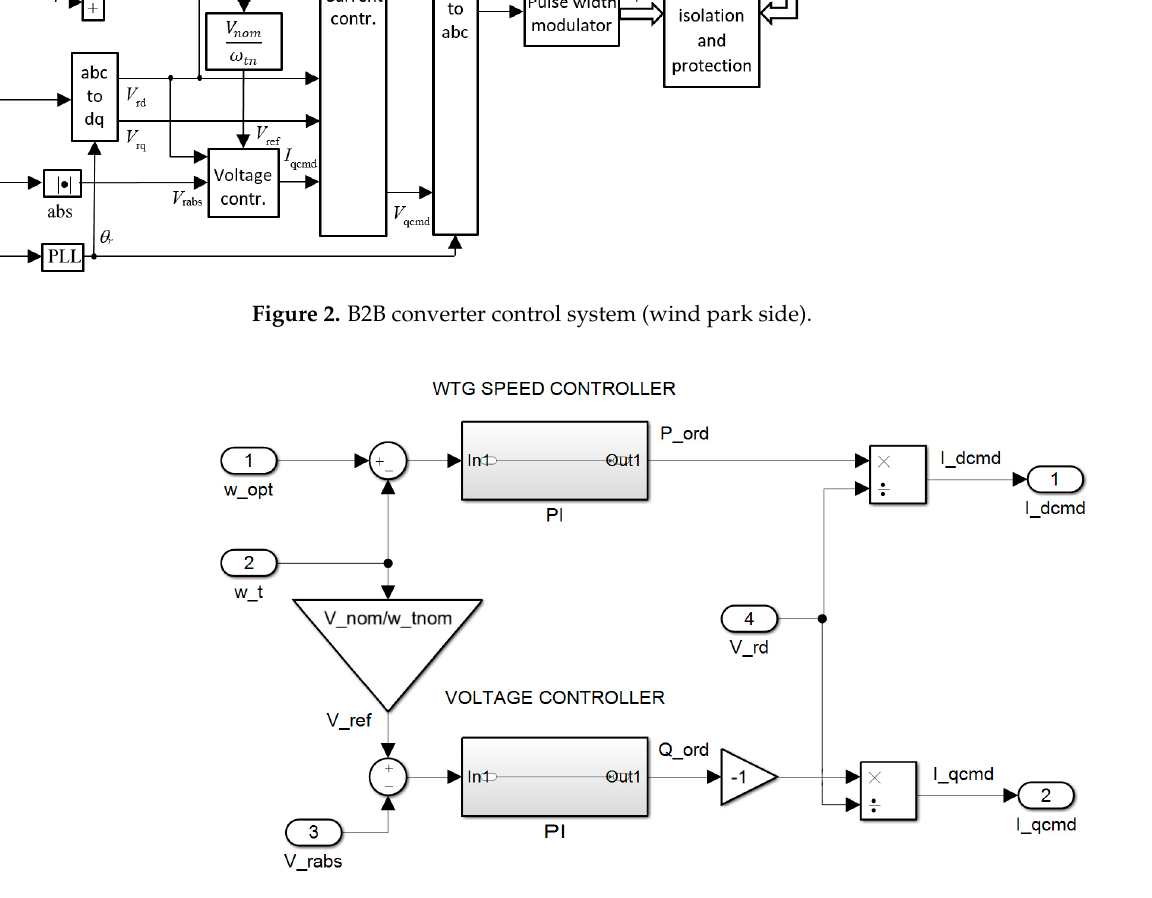
Figure 3. WTG Speed controller and Voltage controller.